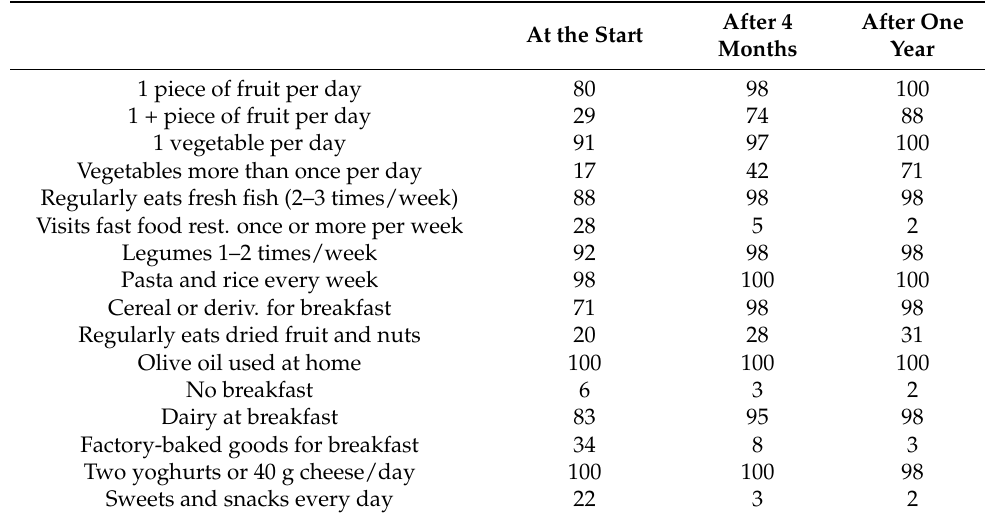
not eat breakfast or who had industrial breakfast pastries decreased, as did the proportion of those who consumed treats on a daily basis. The mean value of the KidMed index at the beginning of the program was 7.09 ± 1.82 points. 52.29% of the patients obtained a qualification according to the KidMed test of “need to improve” and 47.71% obtained the qualification of optimal diet. At the end of the study, 98.6% of the children obtained optimal levels with a mean of 9.21 ± 1.29 points, mean difference of 2.12 ± 0.11 (95% CI: 1.90–2.30 p < 0.01). According to this data, the average value of the KIDMED index evolved from a score considered medium-high at the beginning of the program to an optimal value at the end of the program (Table 7). Table 7. KidMed Test (percentage).